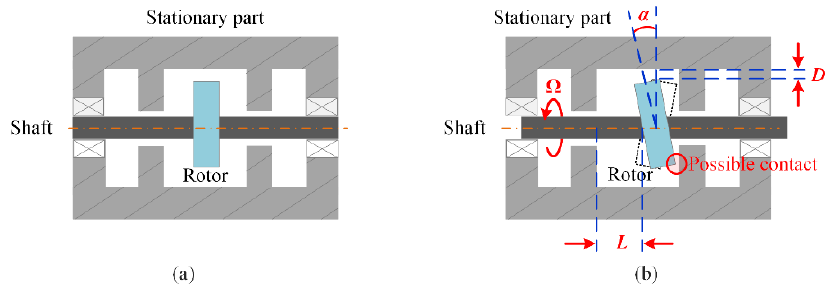
Figure 1. ( a ) The ideal case, and ( b ) the real situation of the running rotor. ( L : axial clearance; D : radial clearance; α : tilt angle; Ω : angular velocity.).